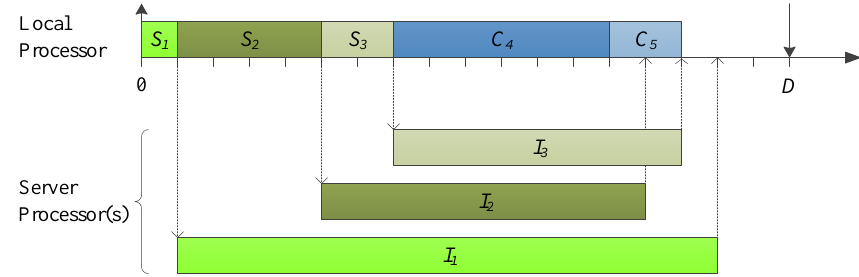
Figure 4 Example of optimal ordering for a set of